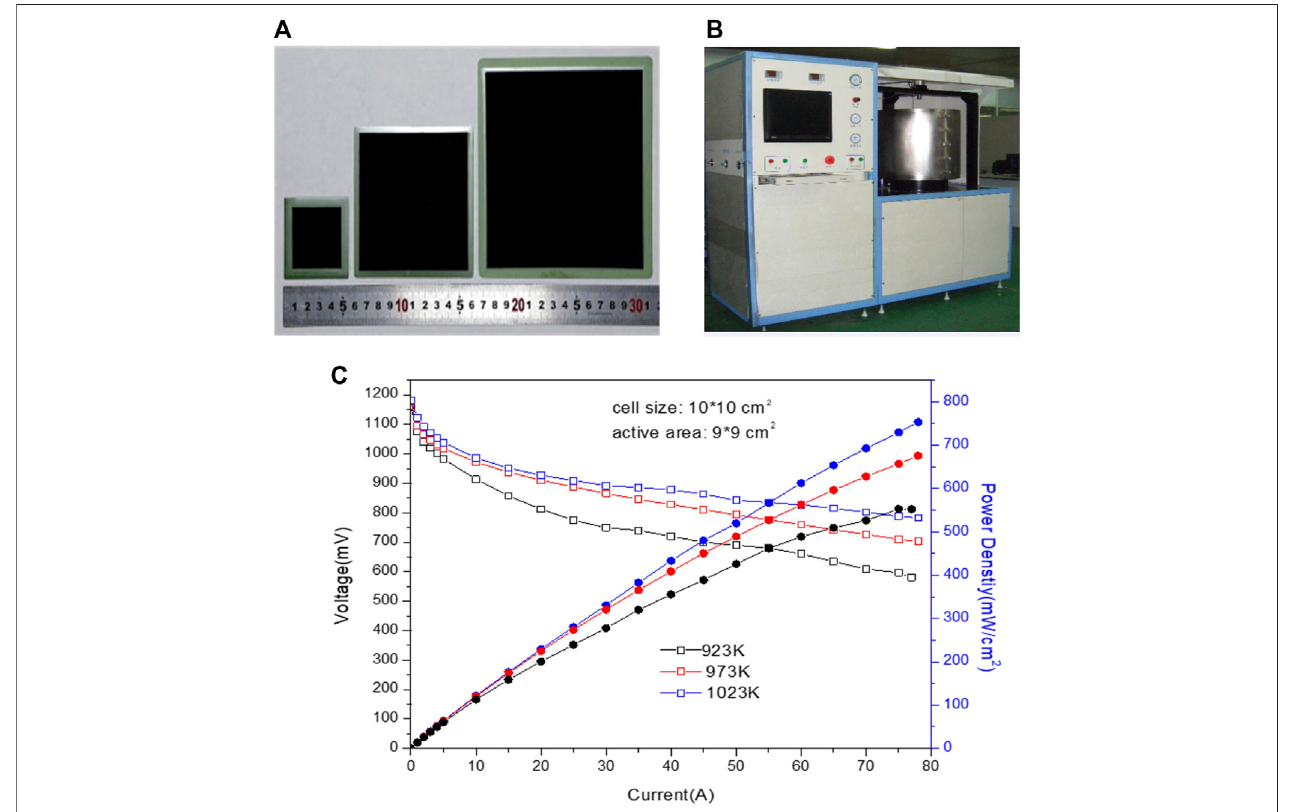
FIGURE 4 | Test of the fuel cells. (A) Fuel cell; (B) test furnace; and (C) electrical characteristics.